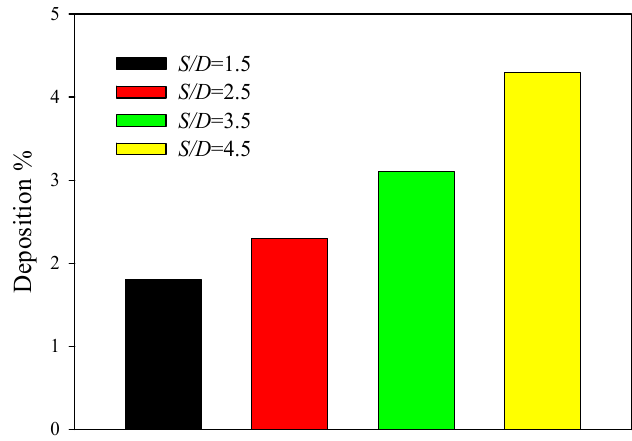
Figure 8. Particle deposition for different values of space ratio at Re = 100, Φ = 0.01, and d p = 0.1 μ m.